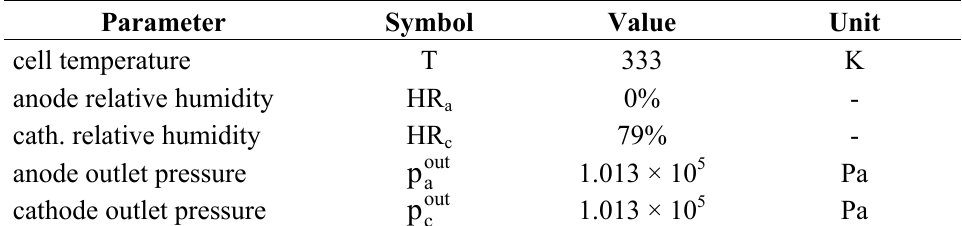
Table 6. Operating conditions.